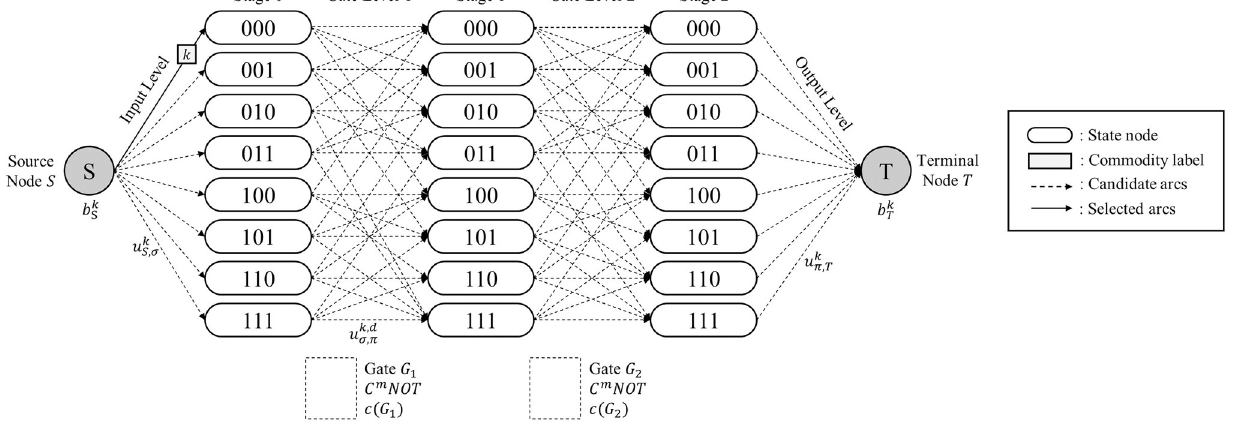
Fig 3. MCNF representation of the QRCS